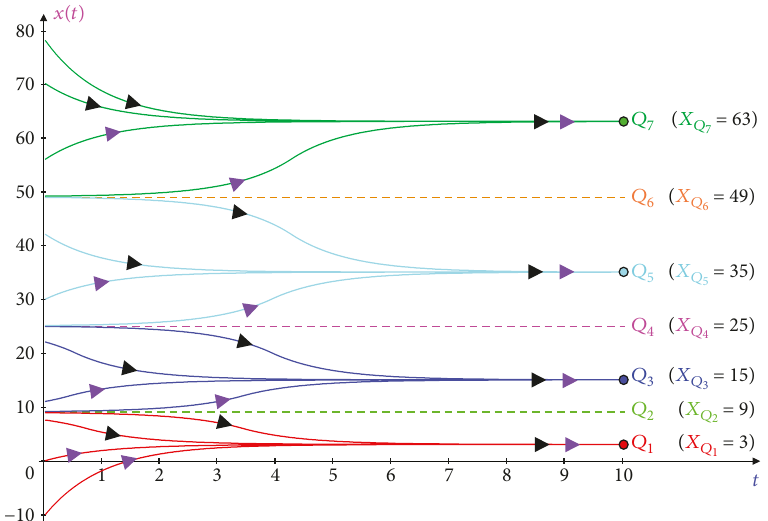
Figure 3: Phase portrait of the stable equilibrium states Q the unstable equilibrium states Q